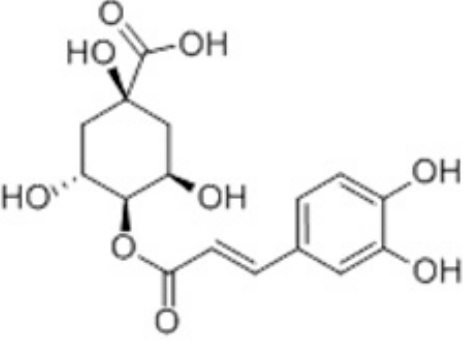
Figure 1. Chemical structure of cryptochlorogenic acid (CCGA).